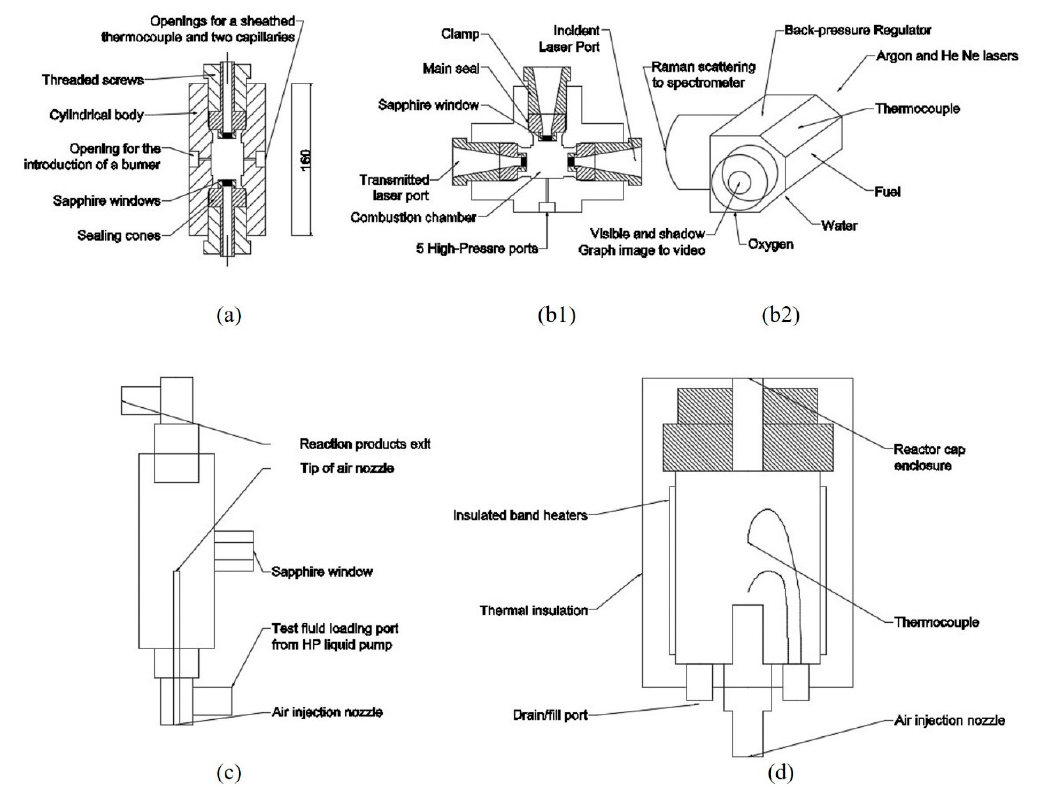
Figure 2. Four kinds of semi-batch reactors ( a ) Karlsruhe Institute of Technology (adapted from [15,67]); ( b1 , b2 ) Sandia National Laboratory (adapted from [48,68]); ( c ) McGill University (adapted from [50,51]); ( d ) NASA John H. Glenn Research Center (adapted from [60]).